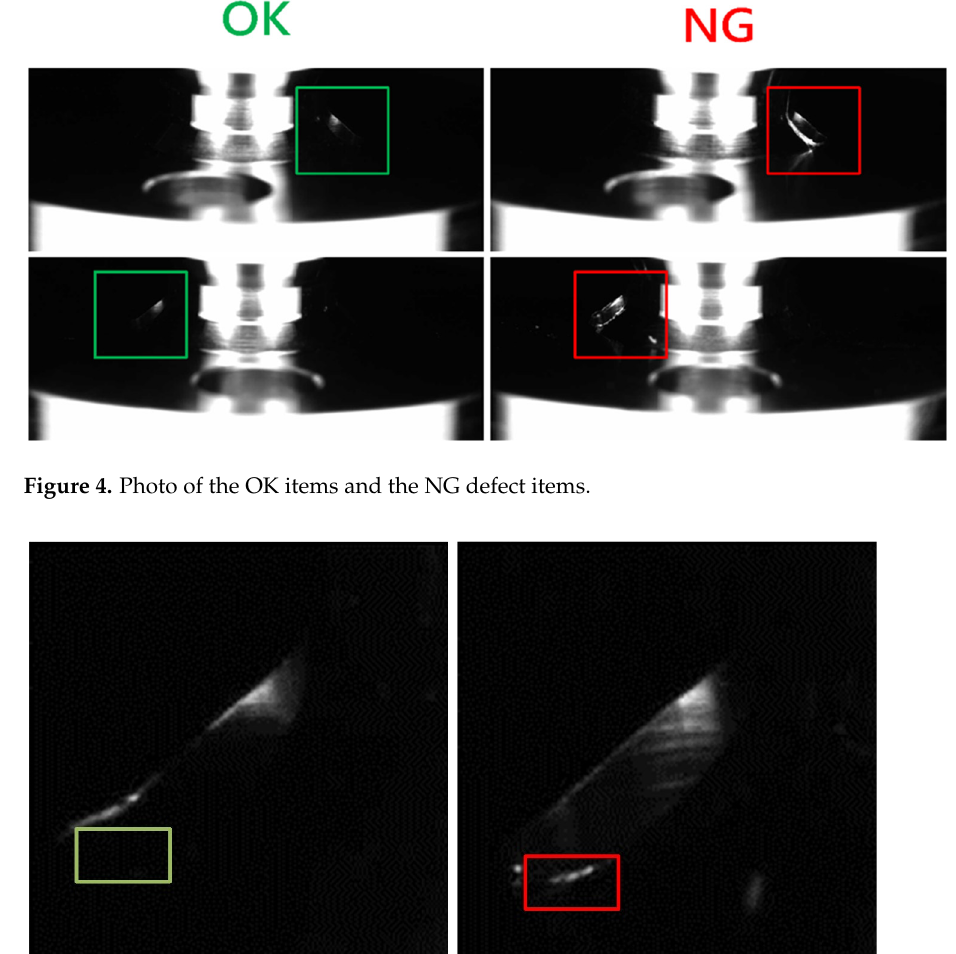
Figure 3. ( a ) Photo of the experimental setup for the in-line system. ( b ) Illustration for the top-view pictured image of the inspection object.